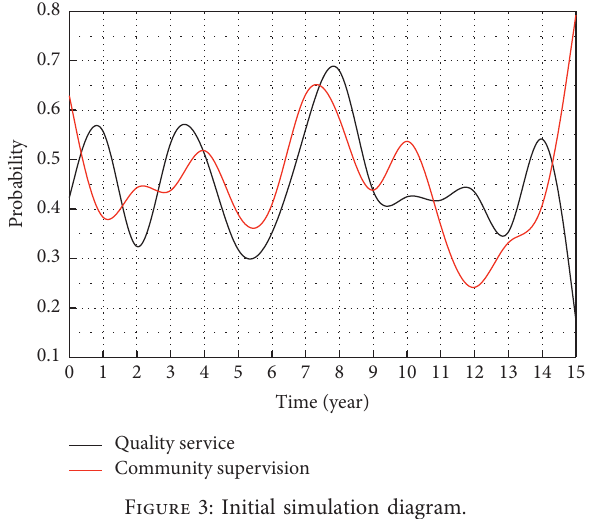
Figure 3: Initial simulation diagram.